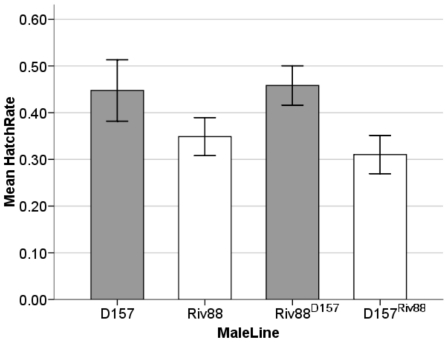
Mean levels of CI induction for males aged 7 days, contrasting the parental strains D157 and Riv88, and the reciprocal backcrosses created from these lines.Host background (normal script) and the infecting Wolbachia (superscript) for each line are noted. The grey and white highlight lines that carry Wolbachia from the same source. Error bars show ±1 SE of the mean.